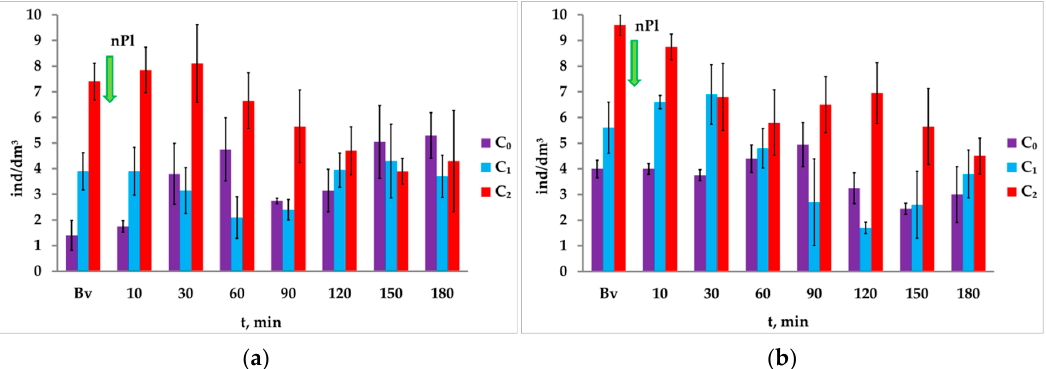
Figure 8. Response of M. salina to paired photostimulation in the presence of nanoplastics at the concentration of 0.1 mg/dm 3 ( a ), 1.0 mg/dm 3 ( b ). C 0 —average concentration of crustaceans before photostimulation; C 1 —average concentration of crustaceans at photostimulation with intensity I 1 (1150 lx); C 2 —average concentration of crustaceans at photostimulation with intensity I 2 (3450 lx); Bv—background value; Green arrow—pollution.